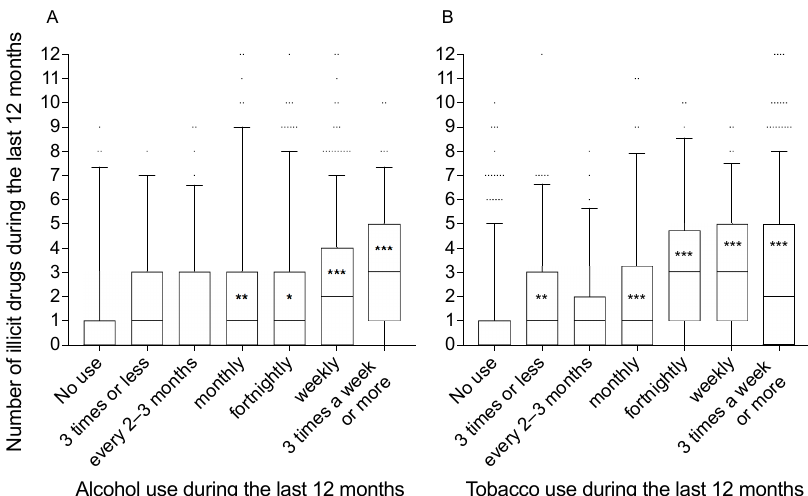
Figure 5. Number of illicit drugs used correlates with frequent alcohol or tobacco use. The number of illicit drugs used during the last 12 months is presented for each category of frequency of alcohol ( A ) or tobacco ( B ) use during the last 12 months. Frequency of alcohol or tobacco are predictors for the number of illicit drugs used (negative binomial regression). * p < 0.05, ** p < 0.01, *** p < 0.001: significant increase in the incidence rates of the number of illicit drugs used compared with the reference category ‘not used in the past 12 months’. Table 5. Binomial logistic regression of illicit drug use during the last 12 months. Due to missing data ( n = 49), 1322 were included in the analysis. All variables are dichotomous or were dichotomized, except for the continuous variable age and for the variable higher education 1 . Factors Wald OR 95% CI p